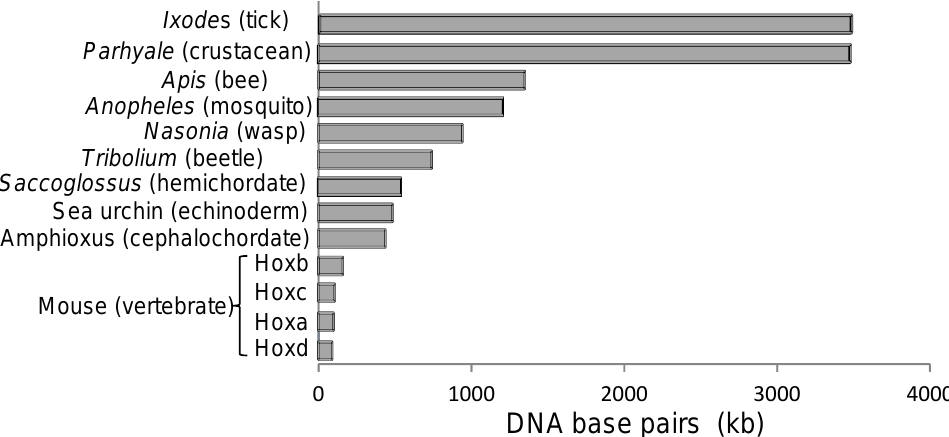
Figure 5. Hox clusters are more compact in vertebrates than in non-vertebrates. Clusters shown are all apparently intact. Sizes shown are from: Ixodes [37]; Parhyale [38]; Apis [39]; Anopheles [37]; Nasonia [37]; Tribolium [40]; Saccoglossus [41]; sea urchin [42]; amphioxus [36]; mouse [37].